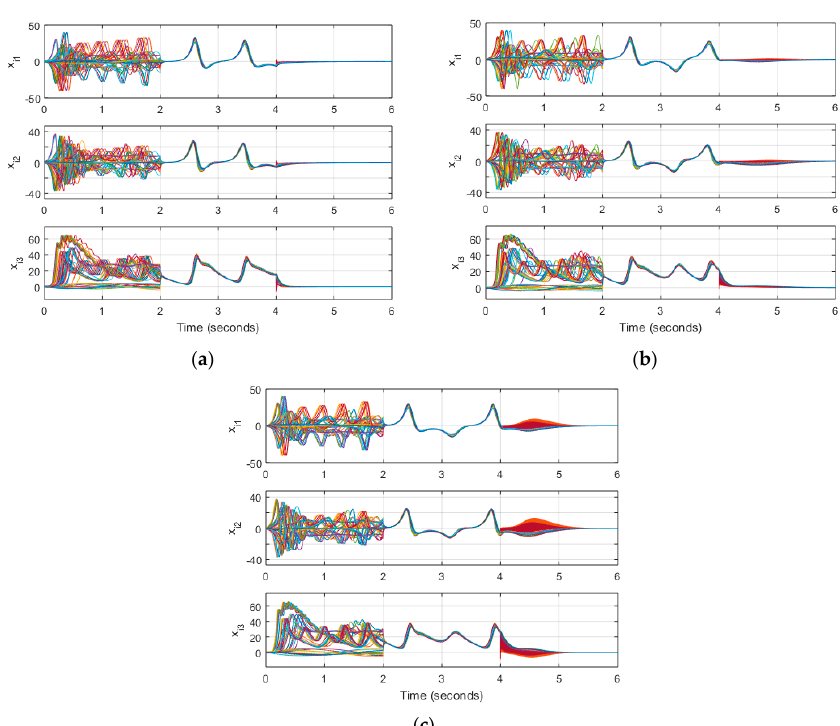
Figure 15. Complex network node dynamics of the fifty ‐ node network with three controlled nodes,